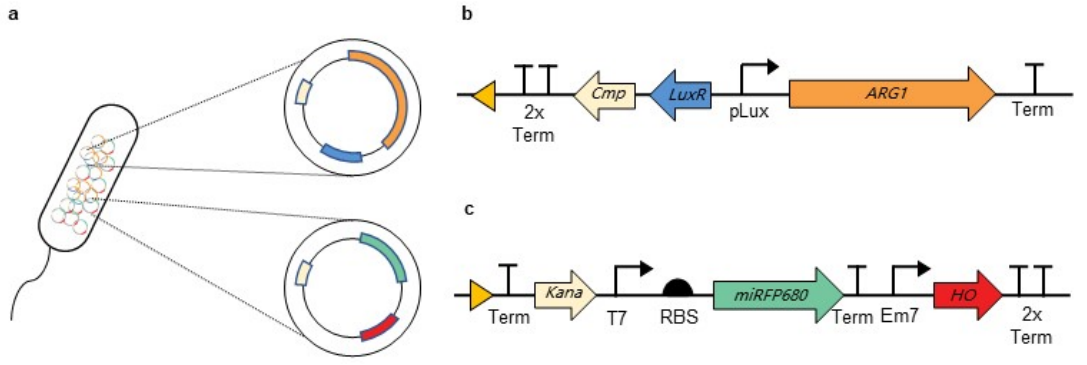
Figure 1. The construction of GVs-miRFP680 MG1655 bacteria. ( a ) Schematic illustration of the GVs-miRFP680 MG1655 bacteria. ( b ) pTD103-ARG1 plasmid map. ARG1 refers to the acoustic reporter gene 1. ( c ) DT012-miRFP680 plasmid map. miRFP680 refers to the monomeric near-infrared fluorescent protein 680. HO refers to heme oxygenase.